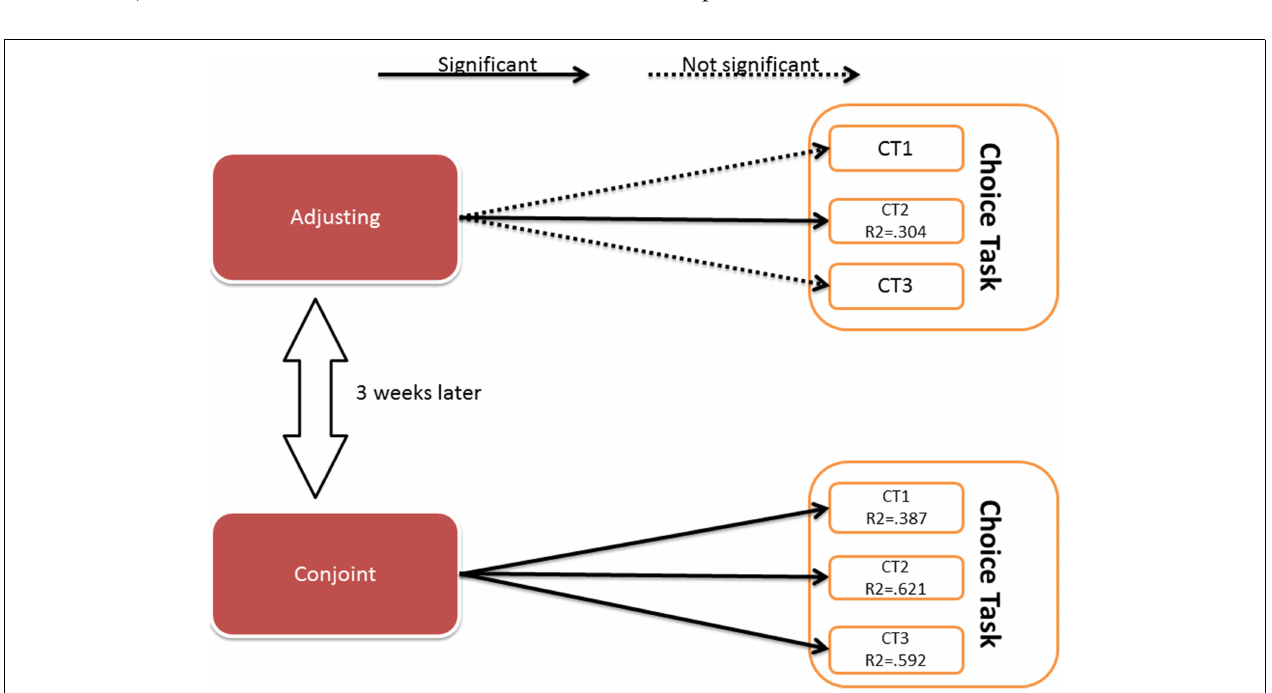
FIGURE 3 | Results of the binary logistic regression. Details of the analysis are presented in the Appendix 1 (Supplementary Material).